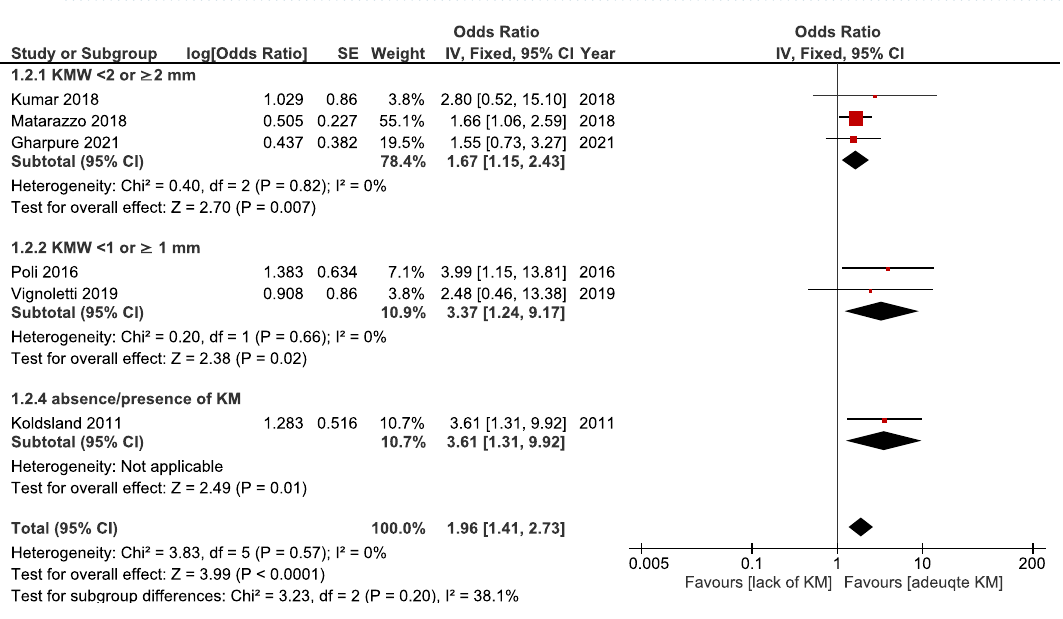
Figure 2. Forest plot to show the effect of lack of keratinized mucosa on developing peri-implantitis.